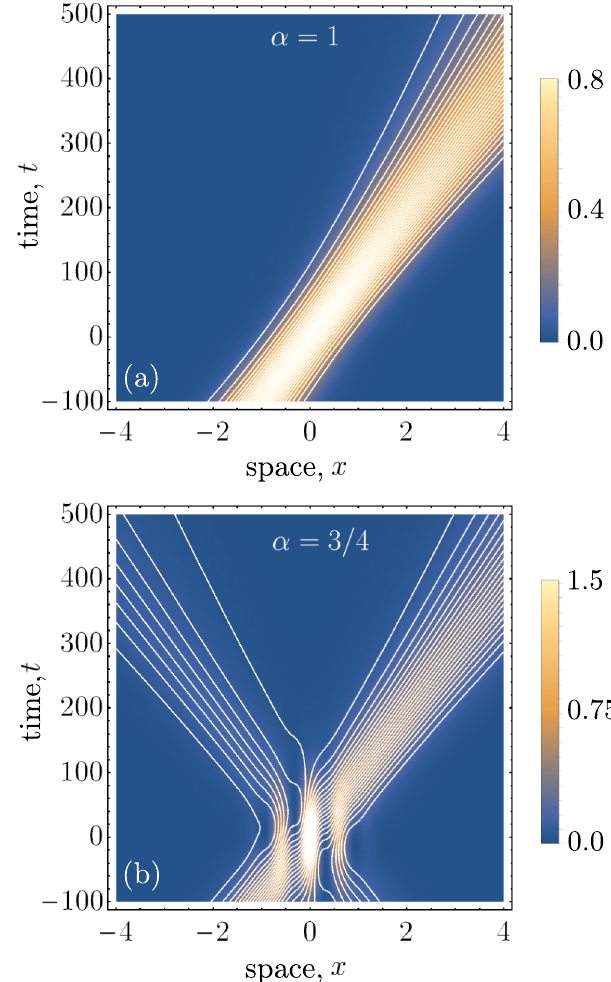
Fig. 5 Plots of the Bohmian trajectories with k 0 / σ = 5, k z / σ = 500. As in the relativistic grazing limit, the particles exhibit dispersion as they propagate in time. Notably, this occurs on a much larger timescale as compared with the relativistic cases.